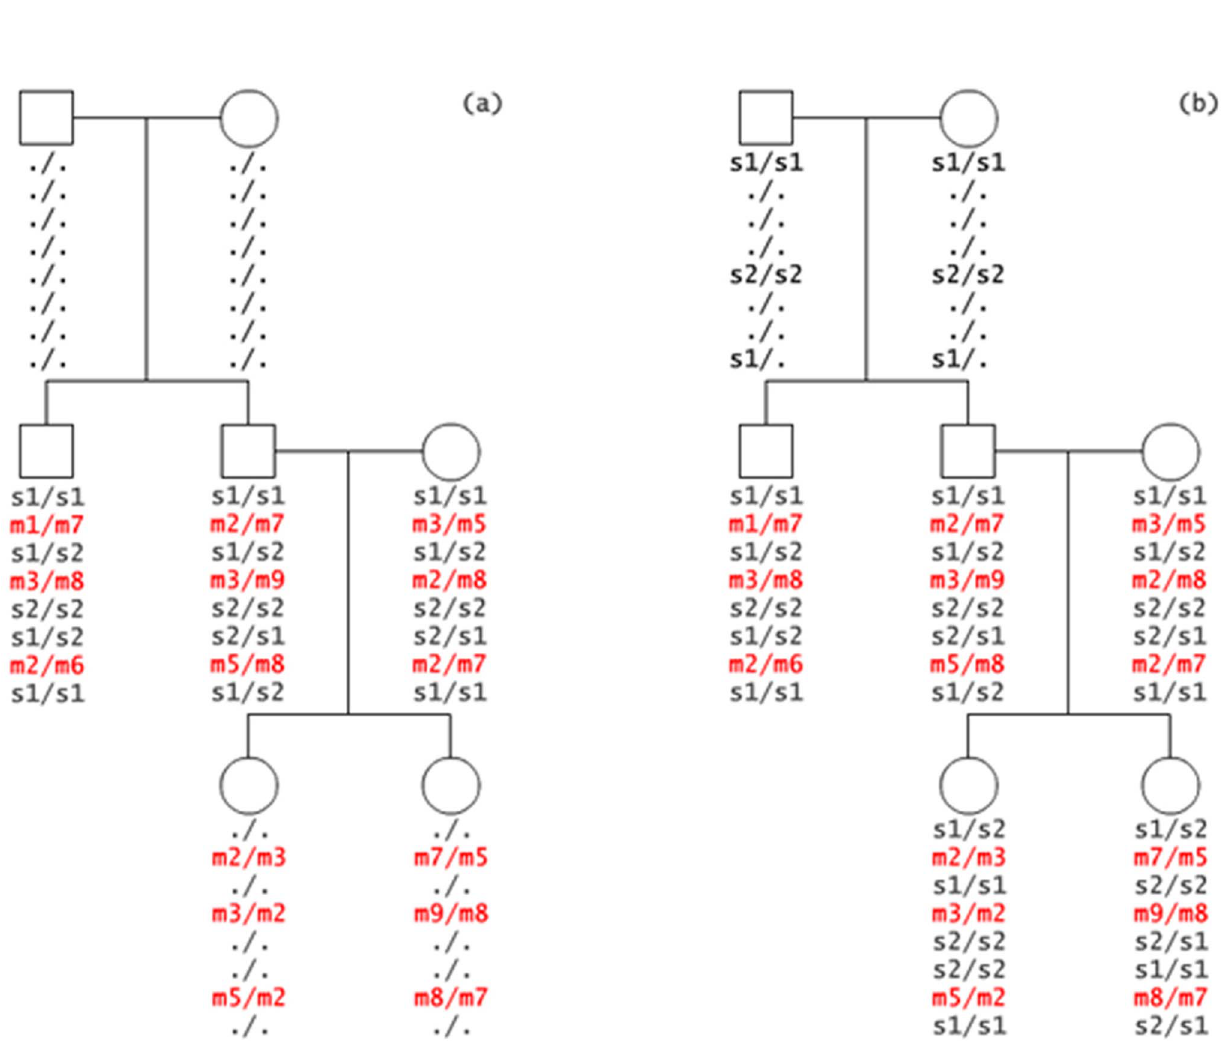
Figure 1. Demonstration of genotype inference within a family. (a) The observed data, which consist of genotypes at a series of microsatellite and SNP markers. A subset of microsatellite markers has been typed in all individuals except for founders (red), whereas both microsatellite and SNP markers have been typed in only a few selected common individuals (black). (b) Genotypes of dense SNPs for missing individuals are inferred by comparing the haplotypes they share with the common individuals.